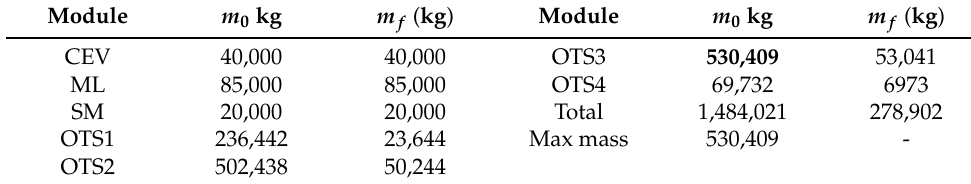
Table 10. Mass scale of